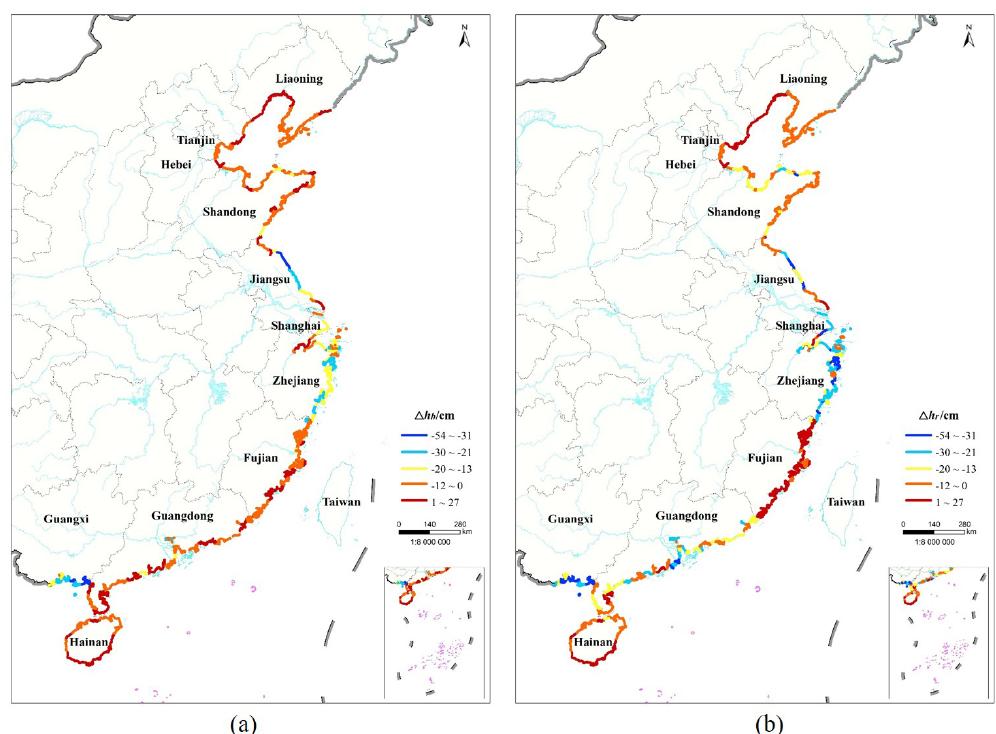
Figure 6. Spatial distribution map of the warning water level correction value: (a) (cid:49)h b ; (b) (cid:49)h r .